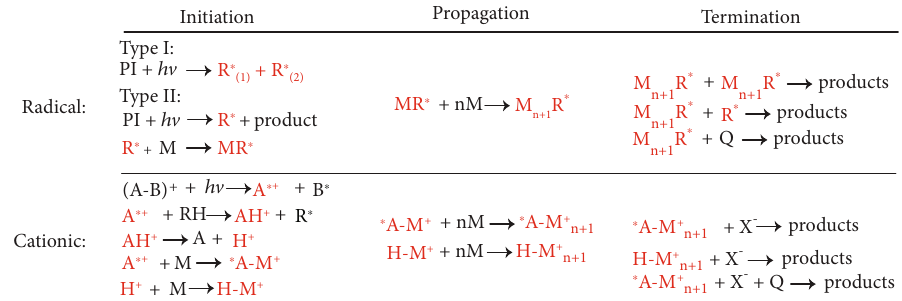
Figure 2: Schematics of radical and cation polymerization reactions initiated by one-photon absorption. h ν : absorbed photon; R ∗ and B ∗ : free radicals; M: monomer; M R ∗ and ∗ A-M + : neutral and cationic macroradicals, respectively; Q: quencher; (A-B) + : cationic initiator; A ∗ + : n +1 n +1 cationic radical; AH + : protonized cation; RH and A: neutral molecules; H + : proton; H-M + : protonized monomer; H-M + polymer; X − : counterion. Red markings show the active ingredient that is either causing the reaction or the result of